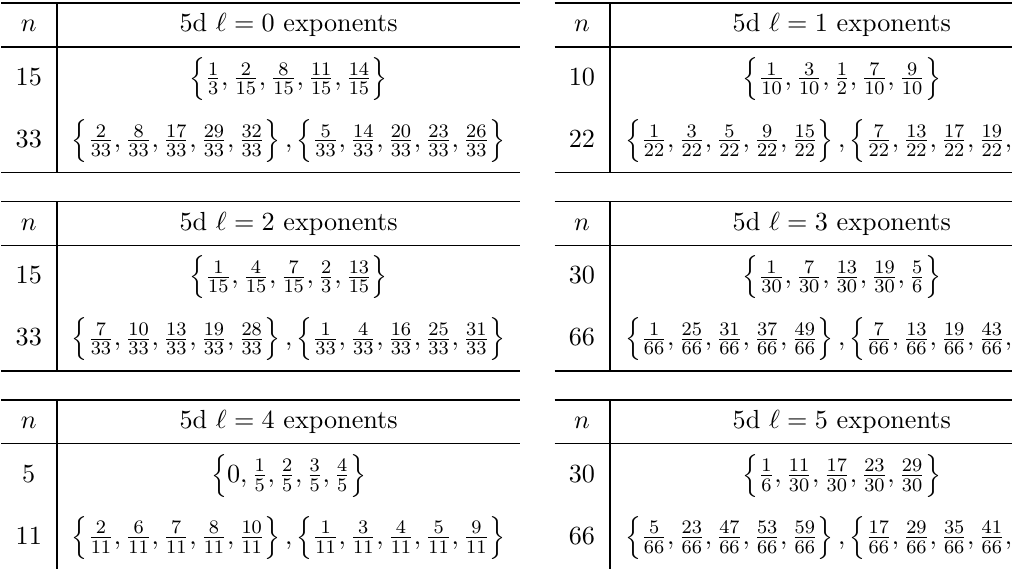
Table 14 . Possible exponents mod 1 for five-character theories, disallowing